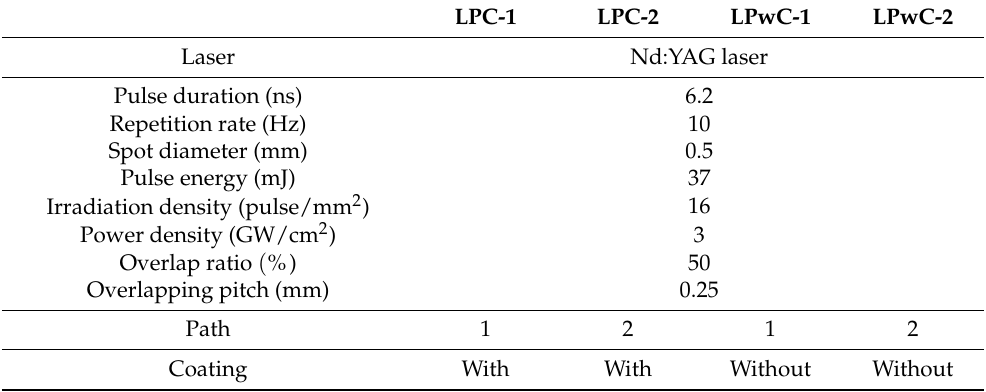
Table 1. LP Table 1. LP parameters.